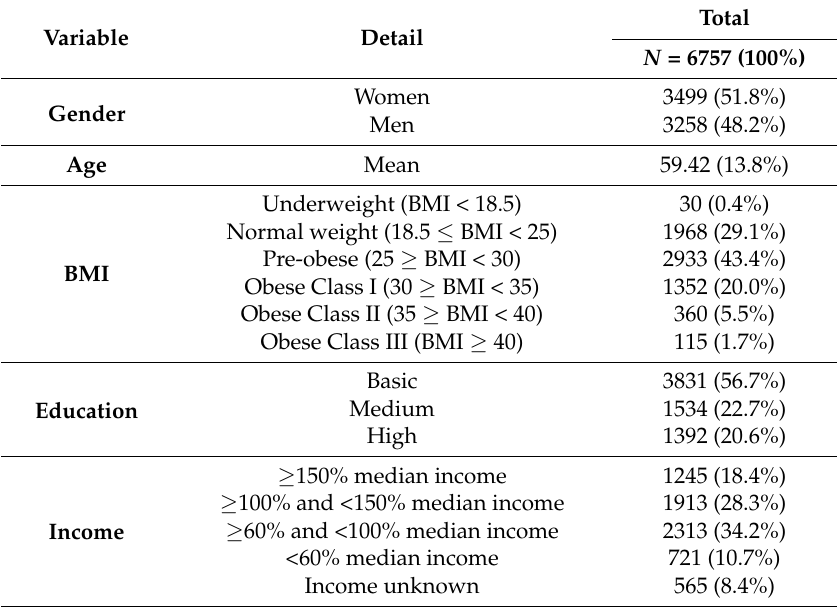
Table 1. Socio-demographic status of the study